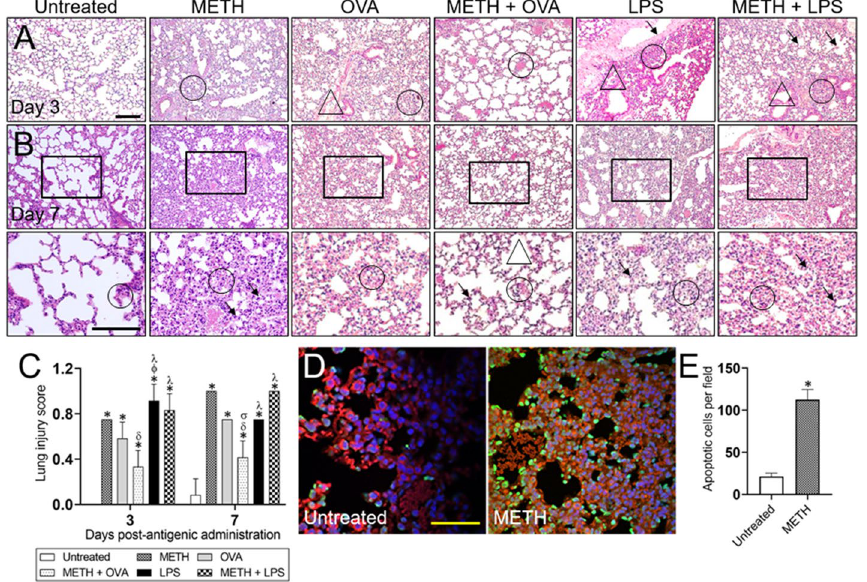
Figure 1. Increasing and prolonged doses of methamphetamine (METH) cause morphological alterations to the pulmonary tissue of C57BL/6 mice. (A) Representative 10 × magnification of hematoxylin and eosin (H&E) stained sections of pulmonary tissue excised from untreated, METH, ovalbumin (OVA), METH + OVA, lipopolysaccharide (LPS), and METH + LPS-treated animals after 3 (upper panel) and 7 (middle panel) days post-Ag administration are shown (scale bar, 100 μm). (B) Magnified (40 ×) black boxes of lung tissue after 7 days (bottom panel) post-Ag administration (scale bar, 100 μm). For panels A and B , circles, triangles, and arrows indicate specific morphological changes explained in the result section. (C) The lung injury score (LIS) was evaluated blindly by two independent investigators. Each bar indicates the average score for 5 fields per image per investigator and error bars indicate standard deviations (STDEV). Bars without error bars denote conditions with no variability in LIS. Symbols (*, , δ, σ, and λ) indicate P value significance ( P < 0.05) calculated using analysis of variance (ANOVA) and adjusted by use of the Tukey’s post-hoc analysis. *, , and λ indicate ϕ significantly higher LIS than in the untreated, OVA, and METH + OVA-treated groups, respectively. δ and σ ϕ indicate significantly lower LIS than in the METH and OVA-treated groups, respectively. The lungs of untreated mice did not show any injury after 3 days post-Ag challenge, therefore, a bar for the group (LIS = 0) is not present. (D) Lung tissue excised from untreated and METH-treated mice ( n = 5 per group) after administration (21 days) were analyzed for apoptosis by fluorescent microscopy after being stained with TUNEL (green nuclei); representative images are presented. The nuclei of viable cells were stained with dapi (blue). (E) Counts of apoptotic cells per field of lung tissue from untreated and METH-treated mice were determined using fluorescent microscopy. Bars indicate the average number of apoptotic cells ( n = 10 images; 10 fields per image; 2 images per mouse; 5 mice per condition) and error bars indicate STDEV. An asterisk (*) indicates P value significance ( P < 0.05) calculated using student’s t -test